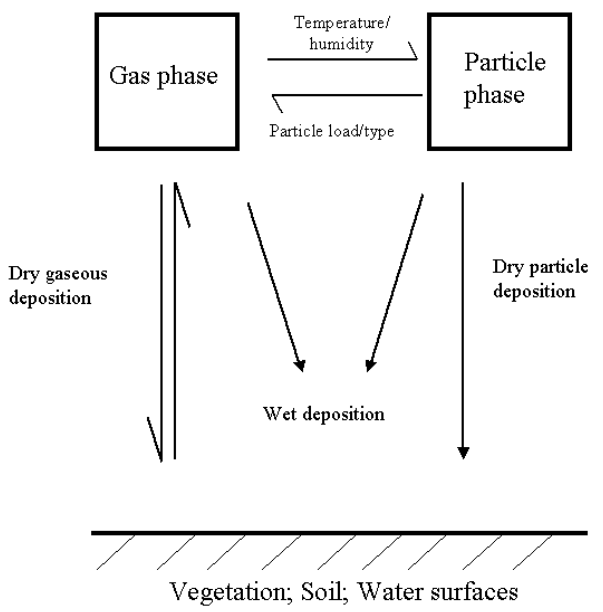
FIGURE 1 . POPs in the atmosphere and their interactions with surfaces.